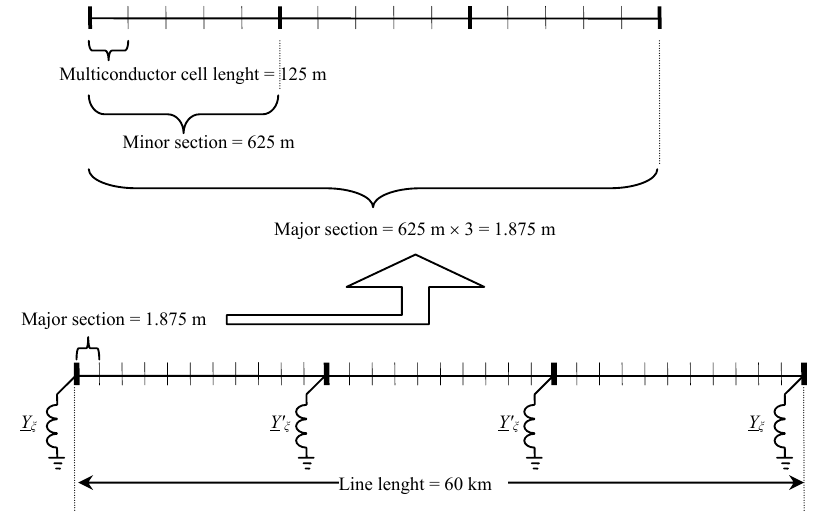
Figure 8. Subdivision of the CB single-circuit cable line with indication of lumped shunt compensation locations.